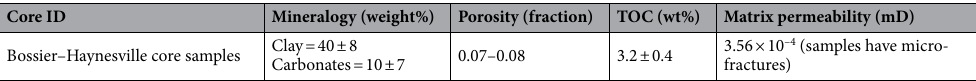
Table 1. Basic properties of shale gas cores used in the laboratory measurements 21,24 .